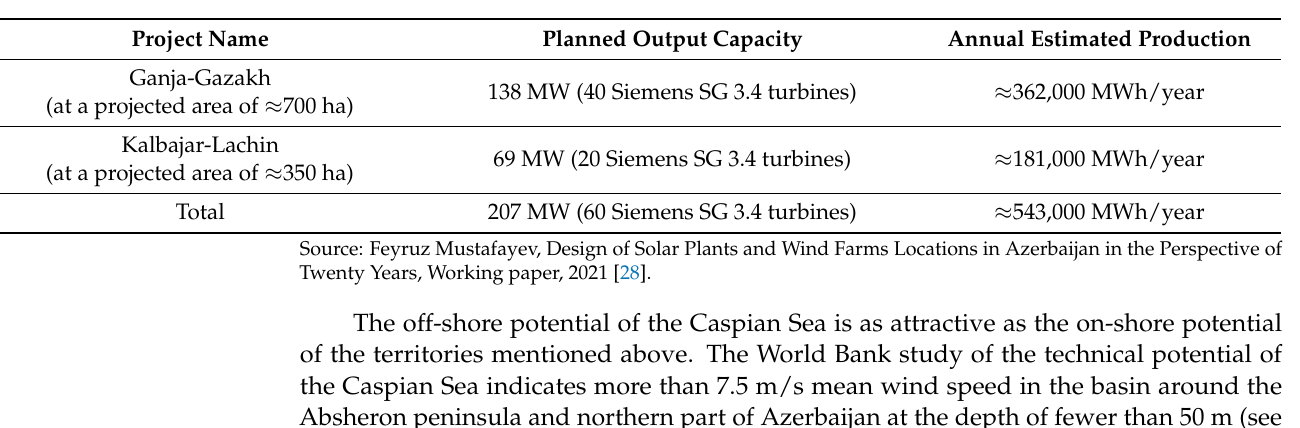
Table 13. Prospective WEPs in the Ganja-Gazakh, and Kalbajar-Lachin